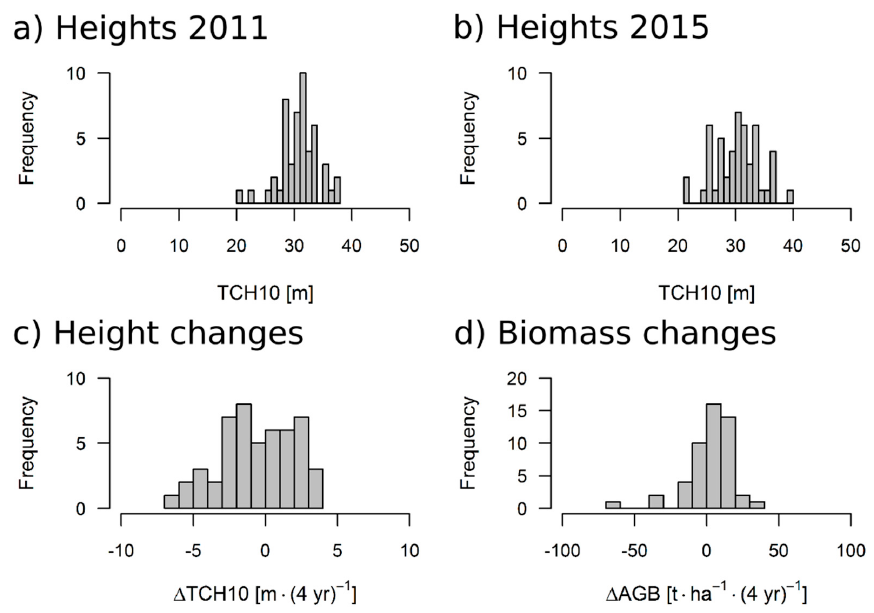
Figure 7. TanDEM-X-derived distributions of ( a , b ) mean top-of-canopy height (TCH10); ( c ) height change ( Δ TCH10) and ( d ) inventory-derived biomass change at 1 ha scale within the 4-year interval. Table 1. R 2 values for the 1:1 relationships of Δ AGB predictions from TanDEM-X data following the three different approaches vs. inventory-based Δ AGB and against each other.